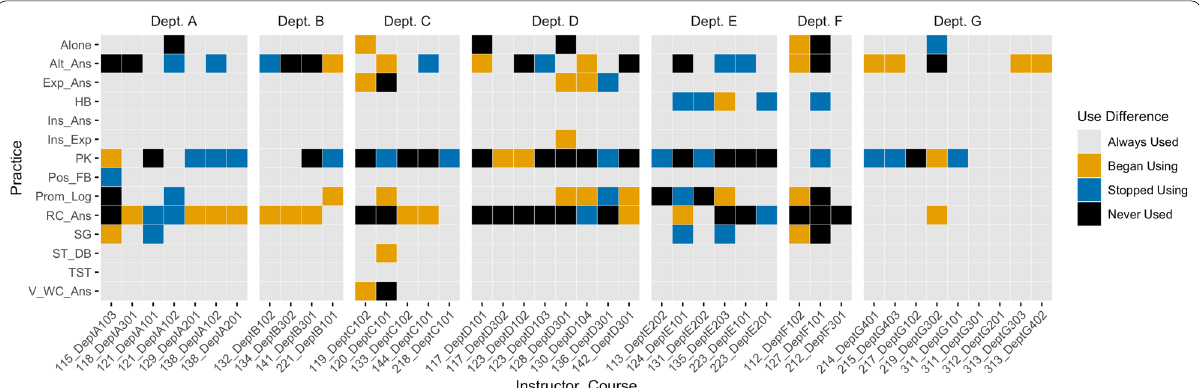
Fig. 2 Changes in presence or absence of PORTAAL practices from T1 to T2. Each column represents the change in use based on the binary values of each PORTAAL practice between timepoints one and two for a paired course. Each x -axis label refers to a Fellow and the paired course